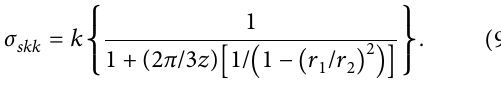
Figure 13: Phase-averaged relative velocity and flow streamlines at the middle span of the impeller: (a) 600r/min 1.0 Q Q BEP , (c) 1000r/min 1.0 Q BEP , (d) 1200r/min 1.0 Q BEP , and (e) 1400r/min 1.0 Q BEP